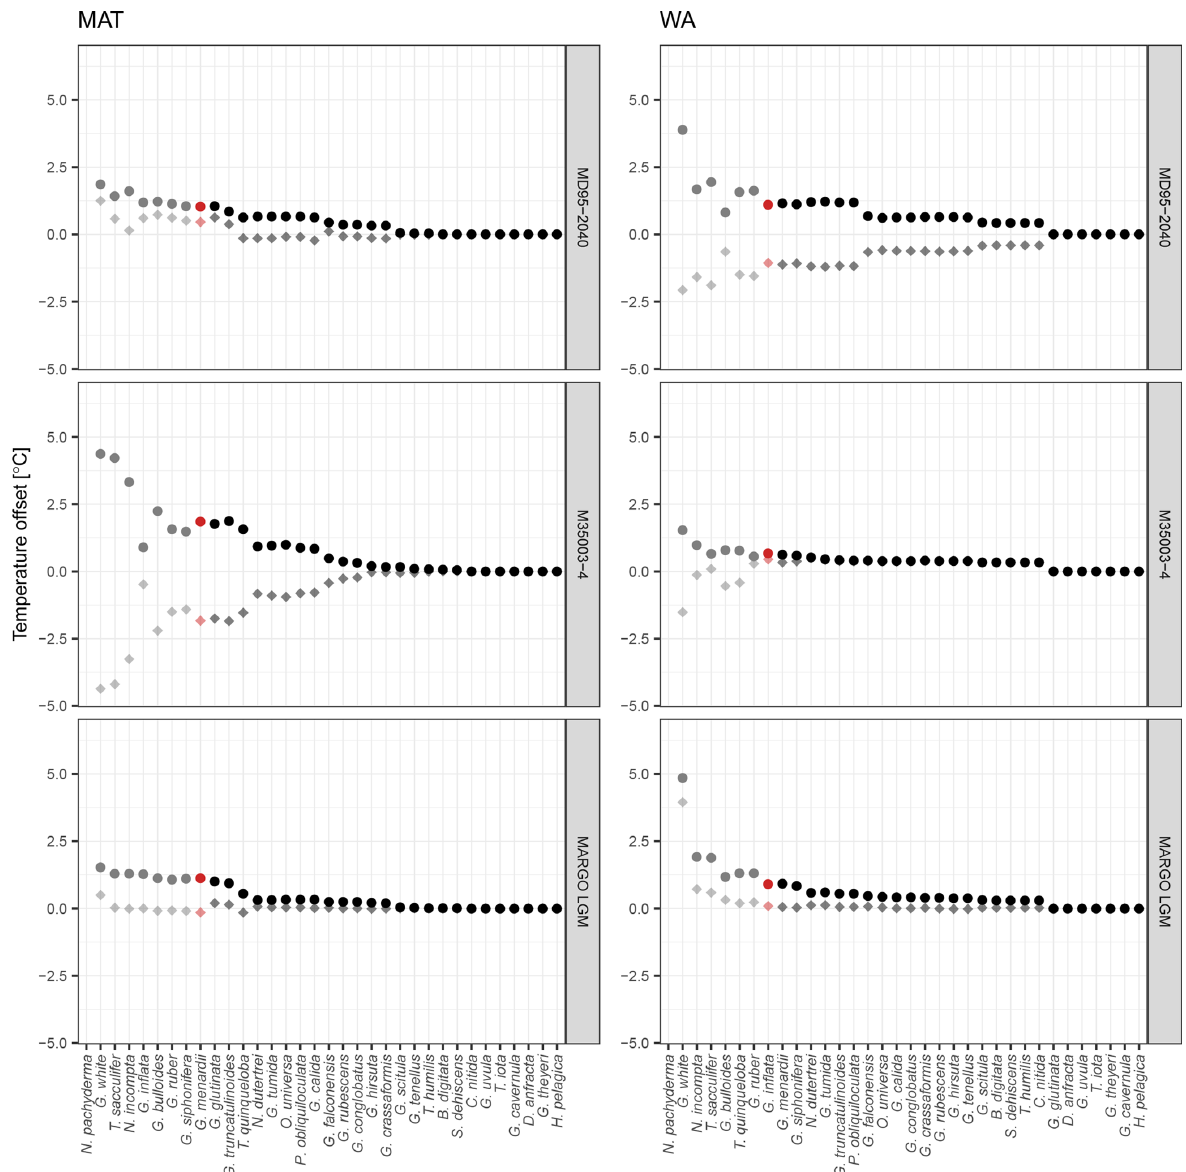
Figure 5. Effect of species selection on SST reconstruction. Graphs show mean difference between reconstructions using species-pruned transfer function models and the model that includes all species. The results are ordered according to species importance, with each dot representing the result from a transfer function model with the species up to the marked point (similar to Fig. 1). Grey symbols are the reconstructions with fewer than the minimum number of species and red symbols the reconstructions with the minimum number of species. Dots are the average of the mean absolute difference, and diamonds are the mean